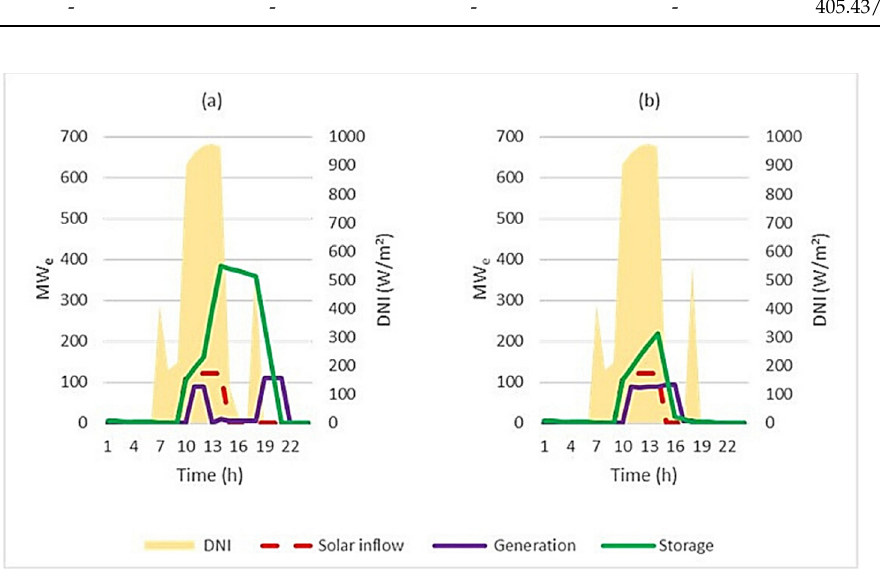
Figure 12. Operation of CSP plant 1 with power reserve in the following scenarios wet/night ( a ) and wet/day ( b ).